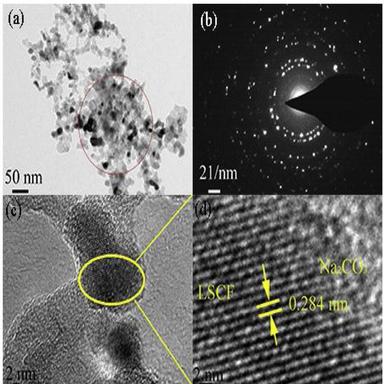
HR-TEM images of the LSCF/ Na2CO3 nanocomposite.